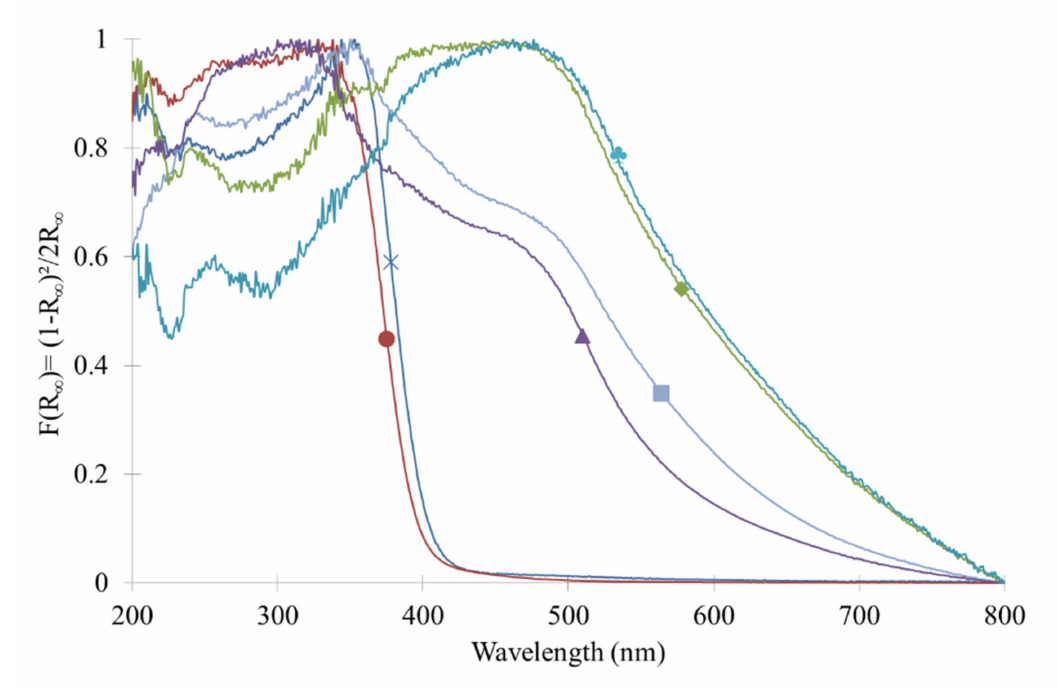
Figure 4. Normalized di ff use reflectance UV / Visible spectra of all calcined samples: ( × ) pure TiO 2 , ( • ) TiO 2 / SiO 2 , ( (cid:4) ) TiO 2 / SiO 2 / Pd1, ( (cid:7) ) TiO 2 / SiO 2 / Pd5, ( (cid:78) ) TiO 2 / SiO 2 / Pd12 and ( ♣ ) TiO 2 / SiO 2 /